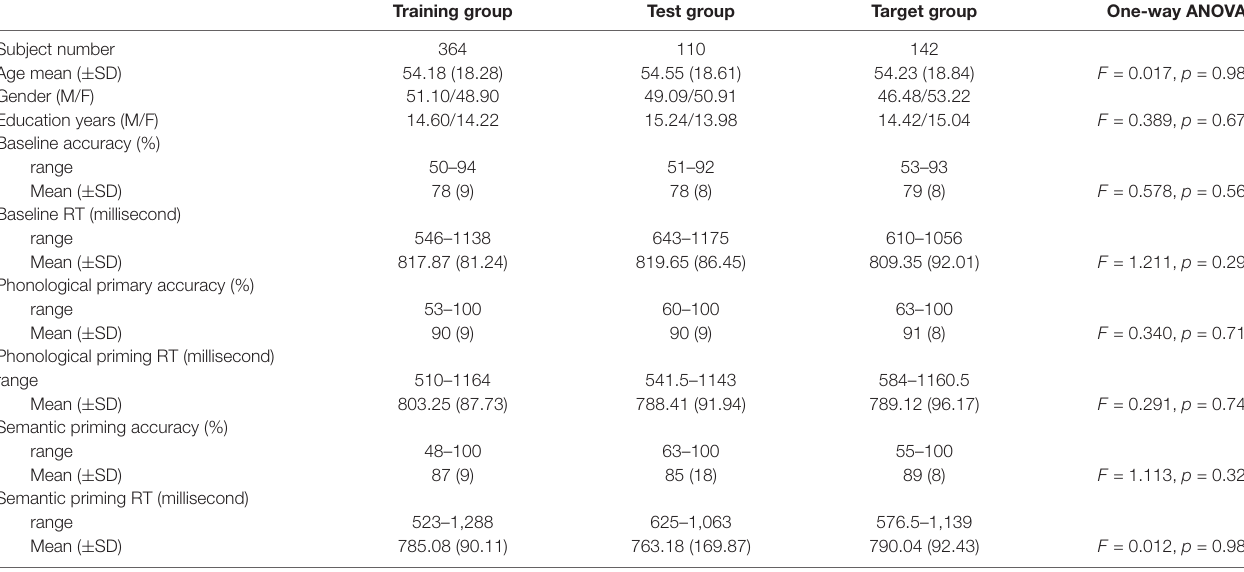
TABLE 1 | Demographics and cognitive performance of the picture-naming task from healthy adults in the Cam-CAN cohort. Training group Test group Target group One-way ANOVA